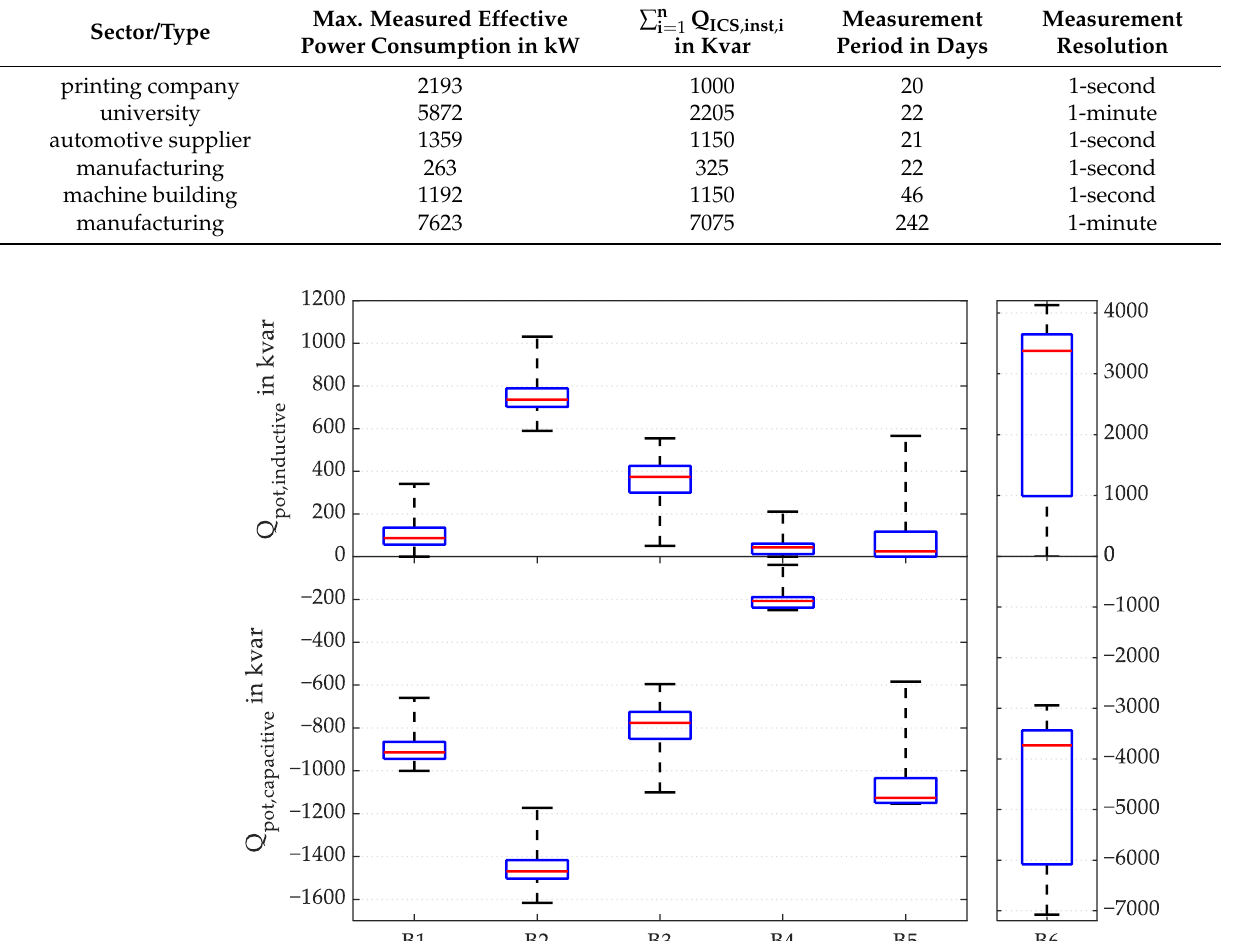
Figure 2. Inductive and capacitive reactive power potential of six measured industrial companies played by boxplots (red lines show the medium, blue boxes show the upper and lower quartiles and